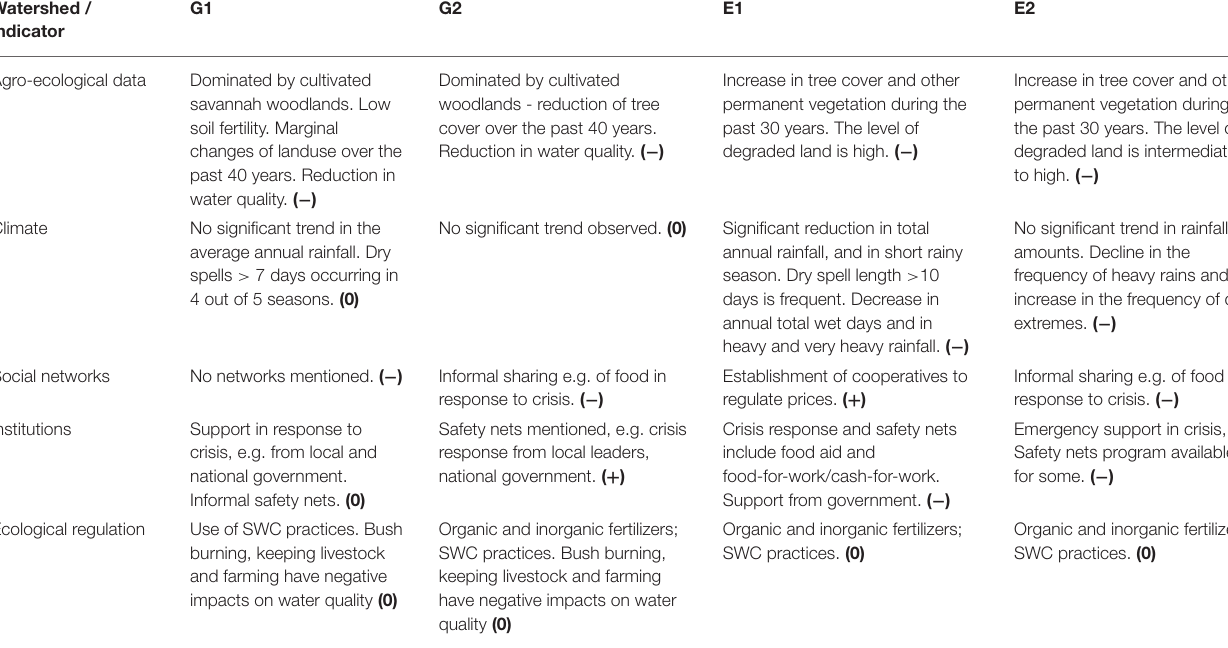
TABLE 6 | Indicator scoring results on contextual factors for the four watersheds G1, G2, E1, E2. Watershed / G1 G2 E1 indicator